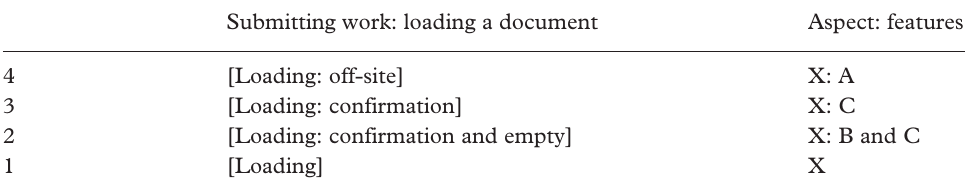
Table 4. Table 2 redrawn with abstract